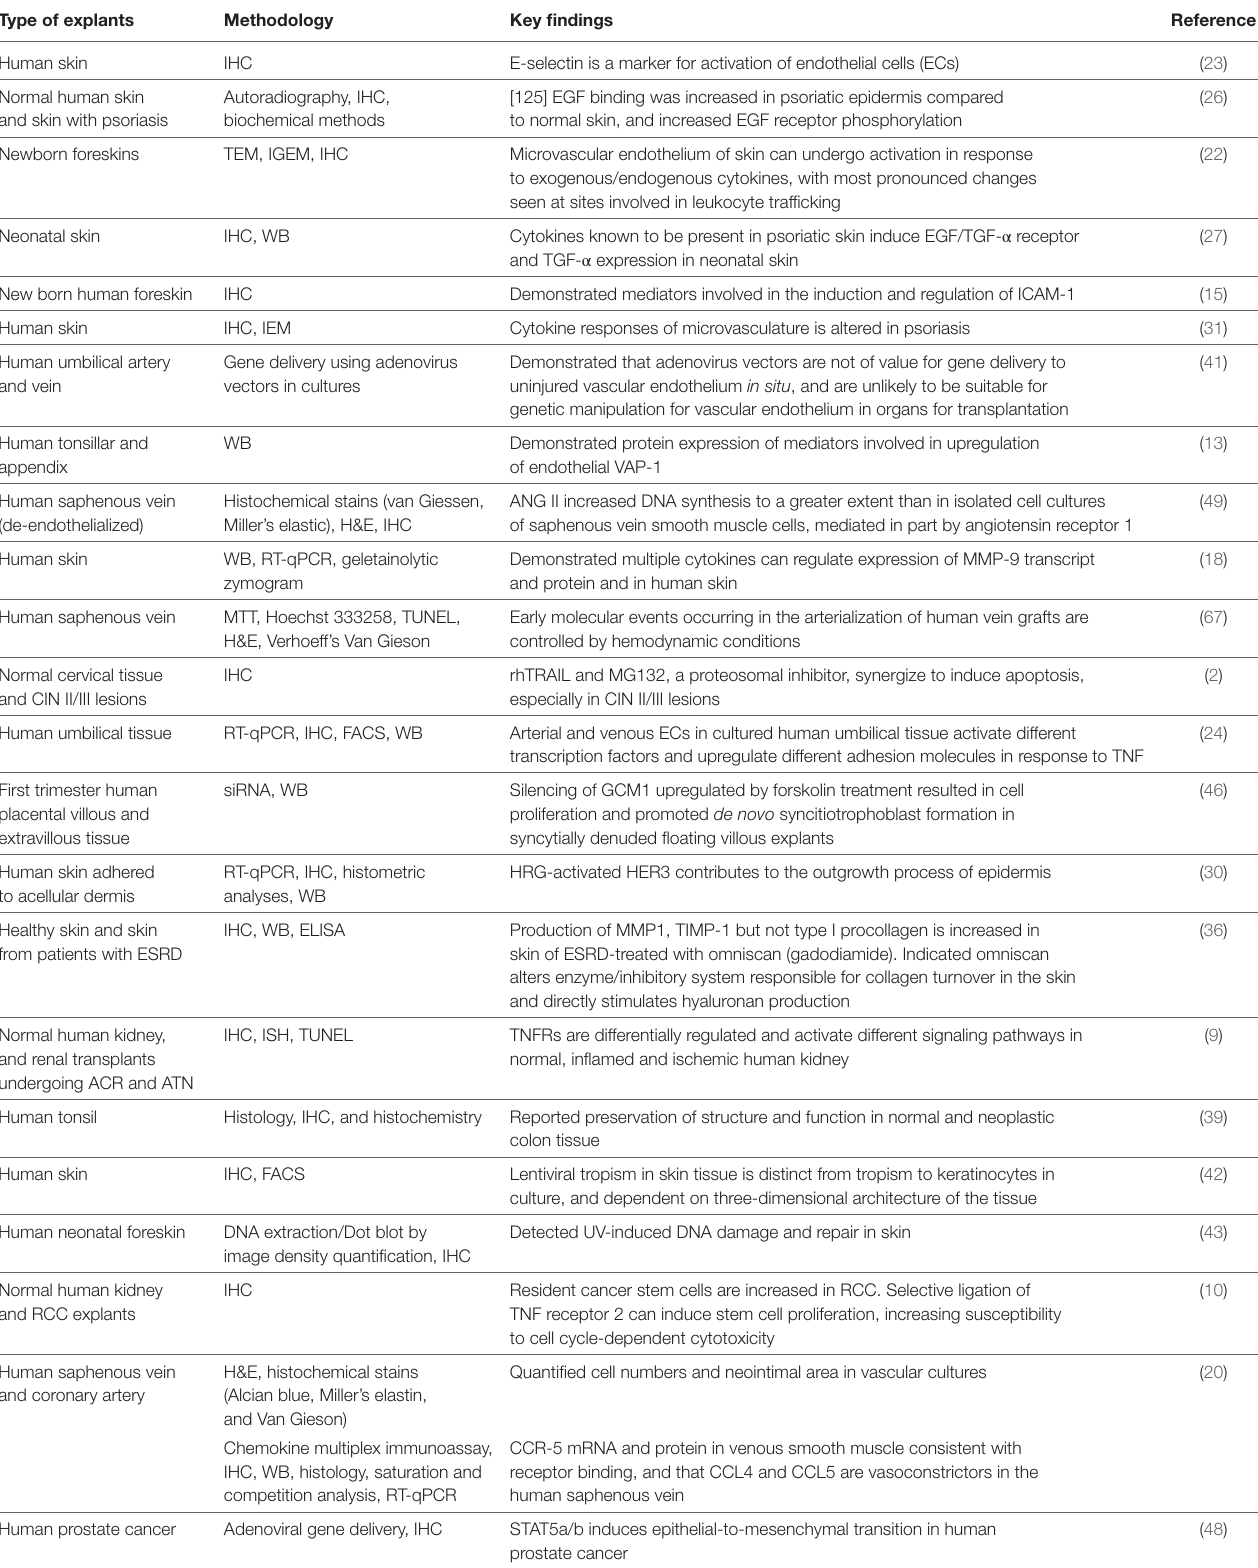
TABLe 1 | Methodologies that can be used to analyze human organ cultures and key